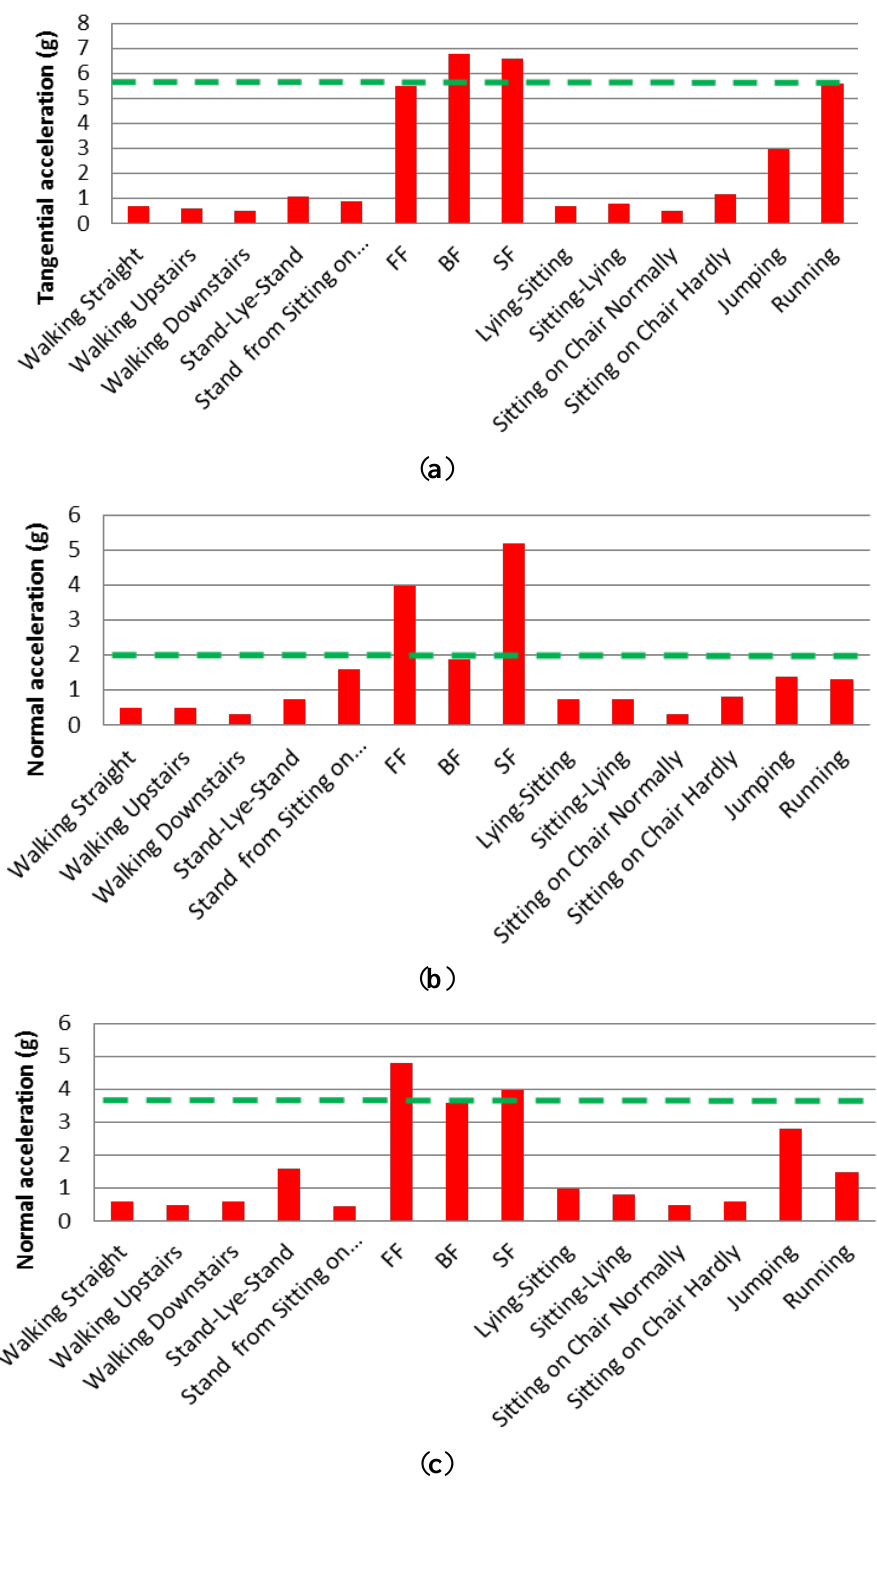
Figure 8. Measured tangential acceleration of ADL and different kind of falls: ( a ) hip; ( b ) chest; ( c )